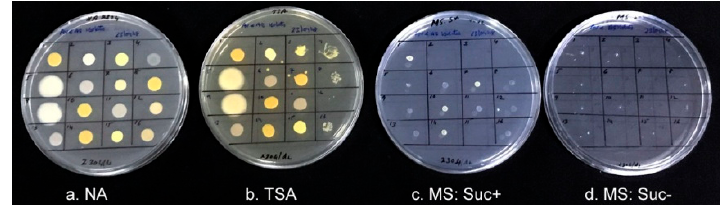
Figure 2. Growth of endophytic bacterial isolates from tomato on four di ff erent enriched media four days after inoculation. ( a ) nutrient agar, ( b ) trypticase soy agar, ( c ), sucrose-plus MS medium, and ( d ), sucrose-minus MS medium; c and d gelled with 3 g L − 1 Phytagel ® ; 1–4, isolates from index-negative seedlings as per Table 2 and 5–16, isolates from index-positive seedlings as per Table 1 (excluding IPS. Ab09